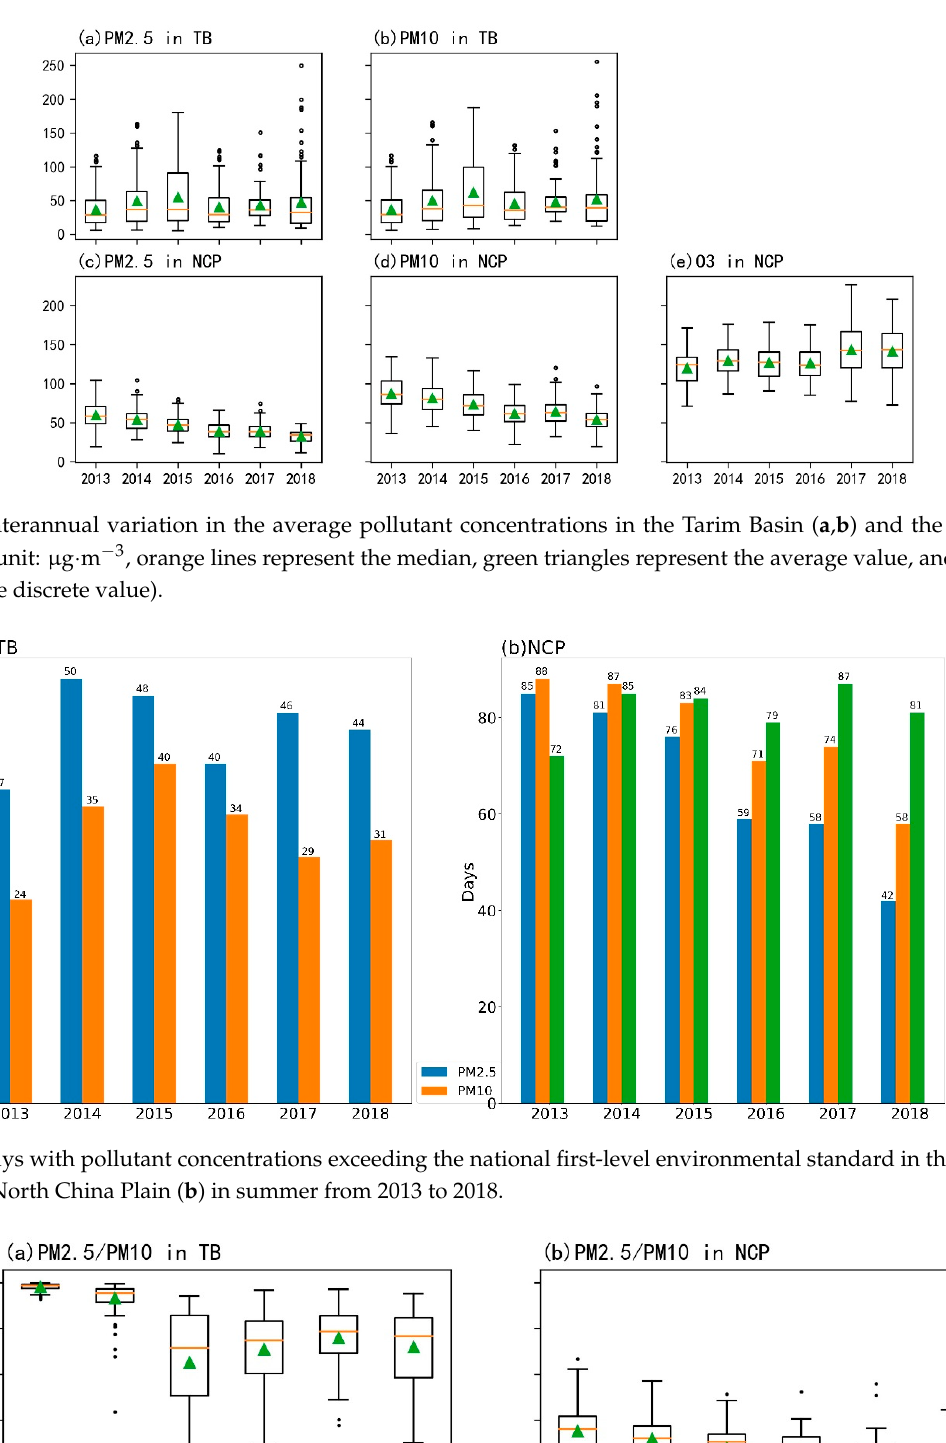
Table 1. Average concentration of pollutants in the Tarim Basin and the North China Plain from 2013 to 2018 (unit: μ g·m − 3 ).